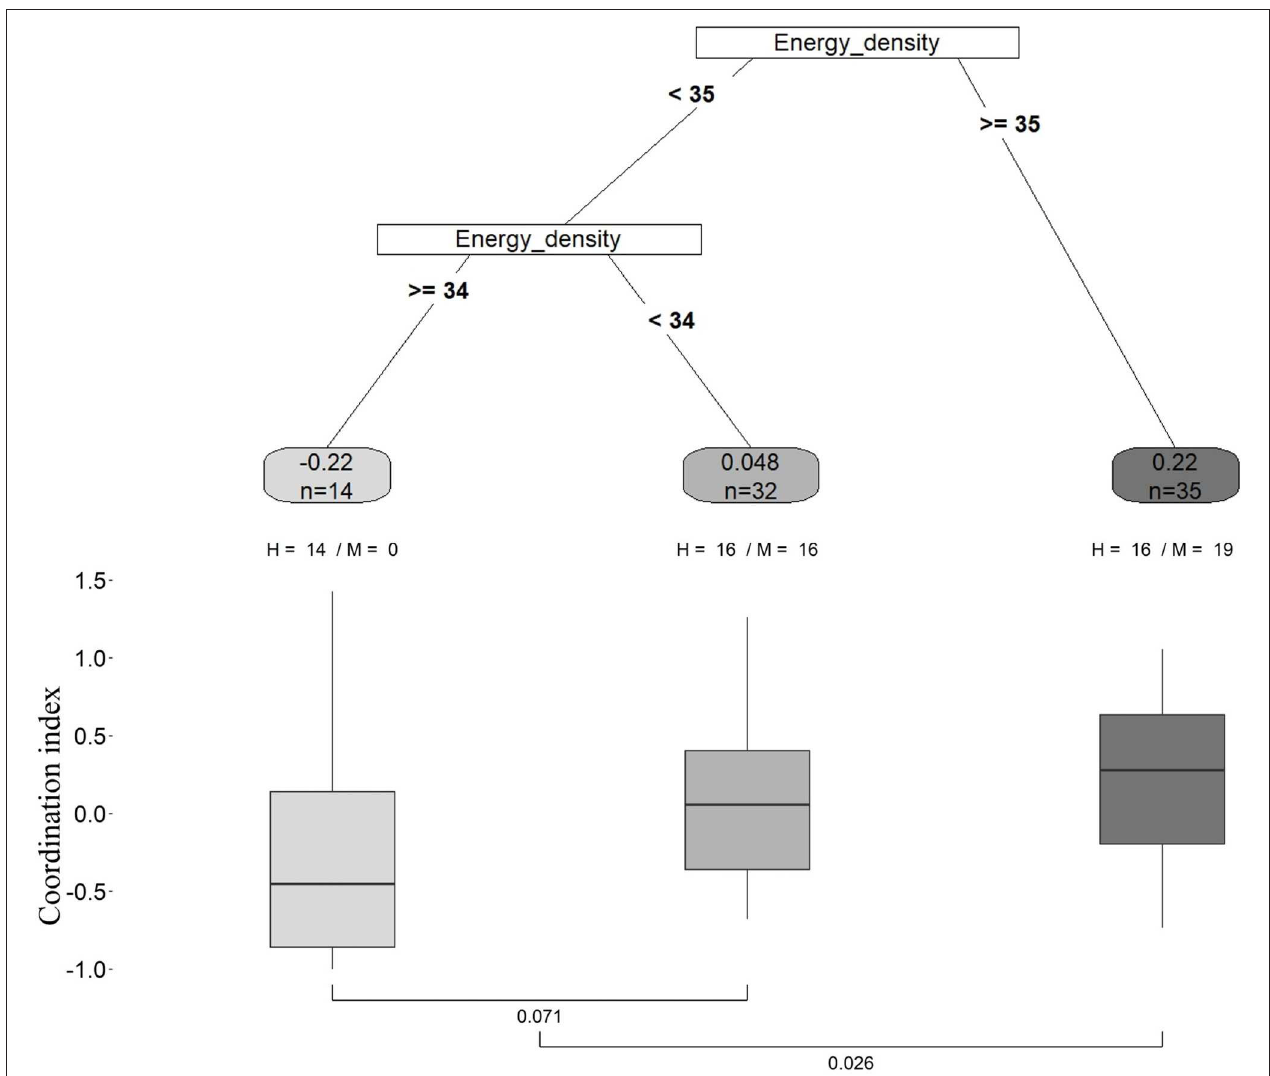
FIGURE 5 | Regression tree obtained with recursive partitioning analysis. The “inverted tree” presents the nodes and branches found by the analysis. The root at the top contains all observations, and is divided into two branches at the node. The group on the left is further split into two subsequent groups. The nodes provide information about the explanatory variable name (in a box) used for the split, and the value used for the split is represented on the branches. Each terminal node (in an oval) is showing the mean of the coordination index and the sample size (n) for the formed group. Proportion of cases from the two colonies in each final group is indicated (H, Hornsund; M, Magdalenefjorden). Boxplots for particular nodes depict the interquartile range of coordination indices of each group, with the median as a bold line and whiskers indicating variability outside the upper and lower quartiles. Inter-group comparisons were made with Mann–Whitney U -tests. Energy_density: Mean total energy density of food load in a given season (in kJ.g − 1